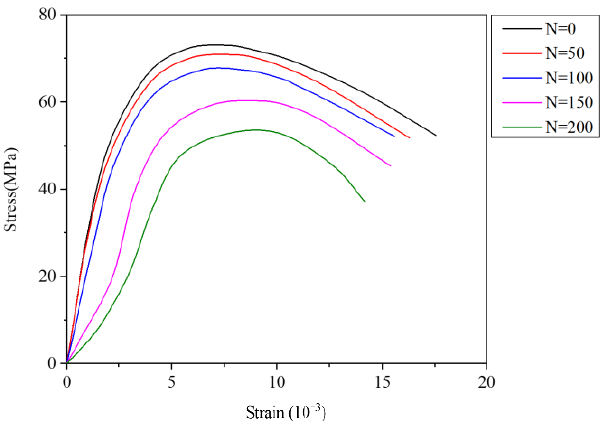
Figure 10. Stress–strain curve of SF10 specimens with 5 MP confining pressure and 10 − 5 /s strain Figure 10. Stress – strain curve of SF10 specimens with 5MP confining pressure and 10 −5 /s strain rate rate under different numbers of F–T cycles. under different numbers of F – T cycles.